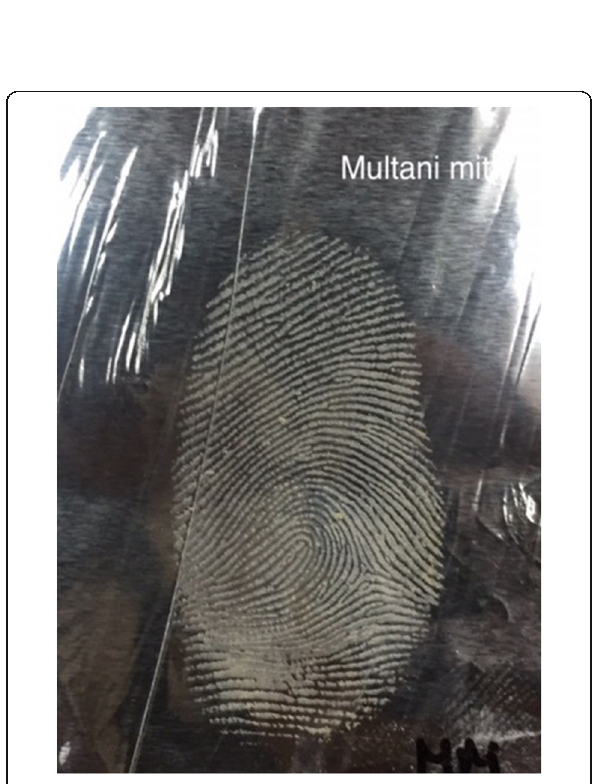
Fig. 10 Development of Latent fingerprint by Fuller ’ s earth powder on Aluminum